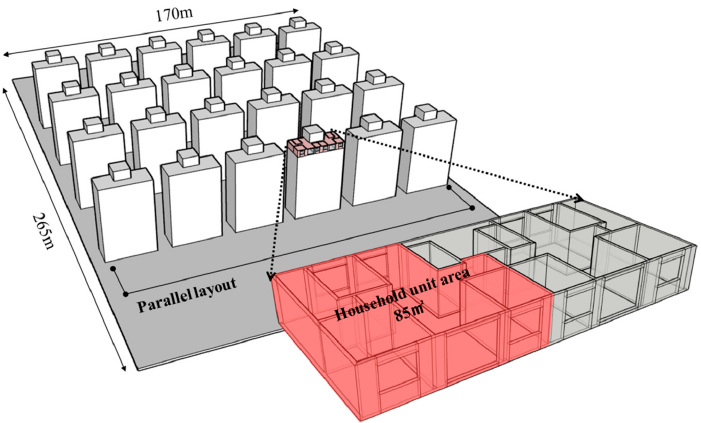
Figure 4. Simulation case model overview.